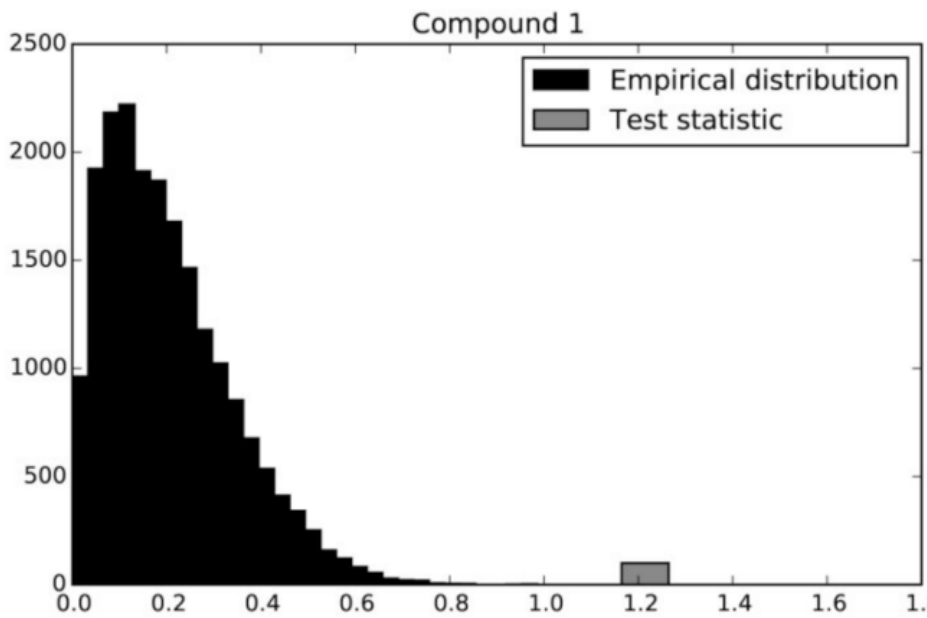
Figure 2. Permutation testing example for compound 1 . The empirical distribution of the F-statistic established by permutations for this compound can be seen in black. The value of the observed statistic is shown in